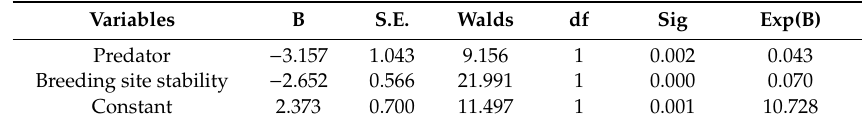
Table 4. Positive parameters determining the presence of Cx. pipiens complex larvae in water bodies in Lhasa by logistic regression